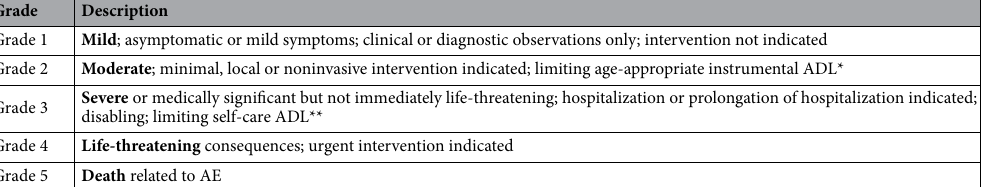
Table 1. Common terminology criteria for adverse events. Table adapted from the US Department of Health and Human Services 1 . *Instrumental ADL refers to preparing meals, shopping for groceries or clothes, using the telephone, managing money, etc. **Self-care ADL refers to bathing, dressing and undressing, feeding self, using the toilet, taking medications, and not bedridden. Abbreviations: activities of daily living